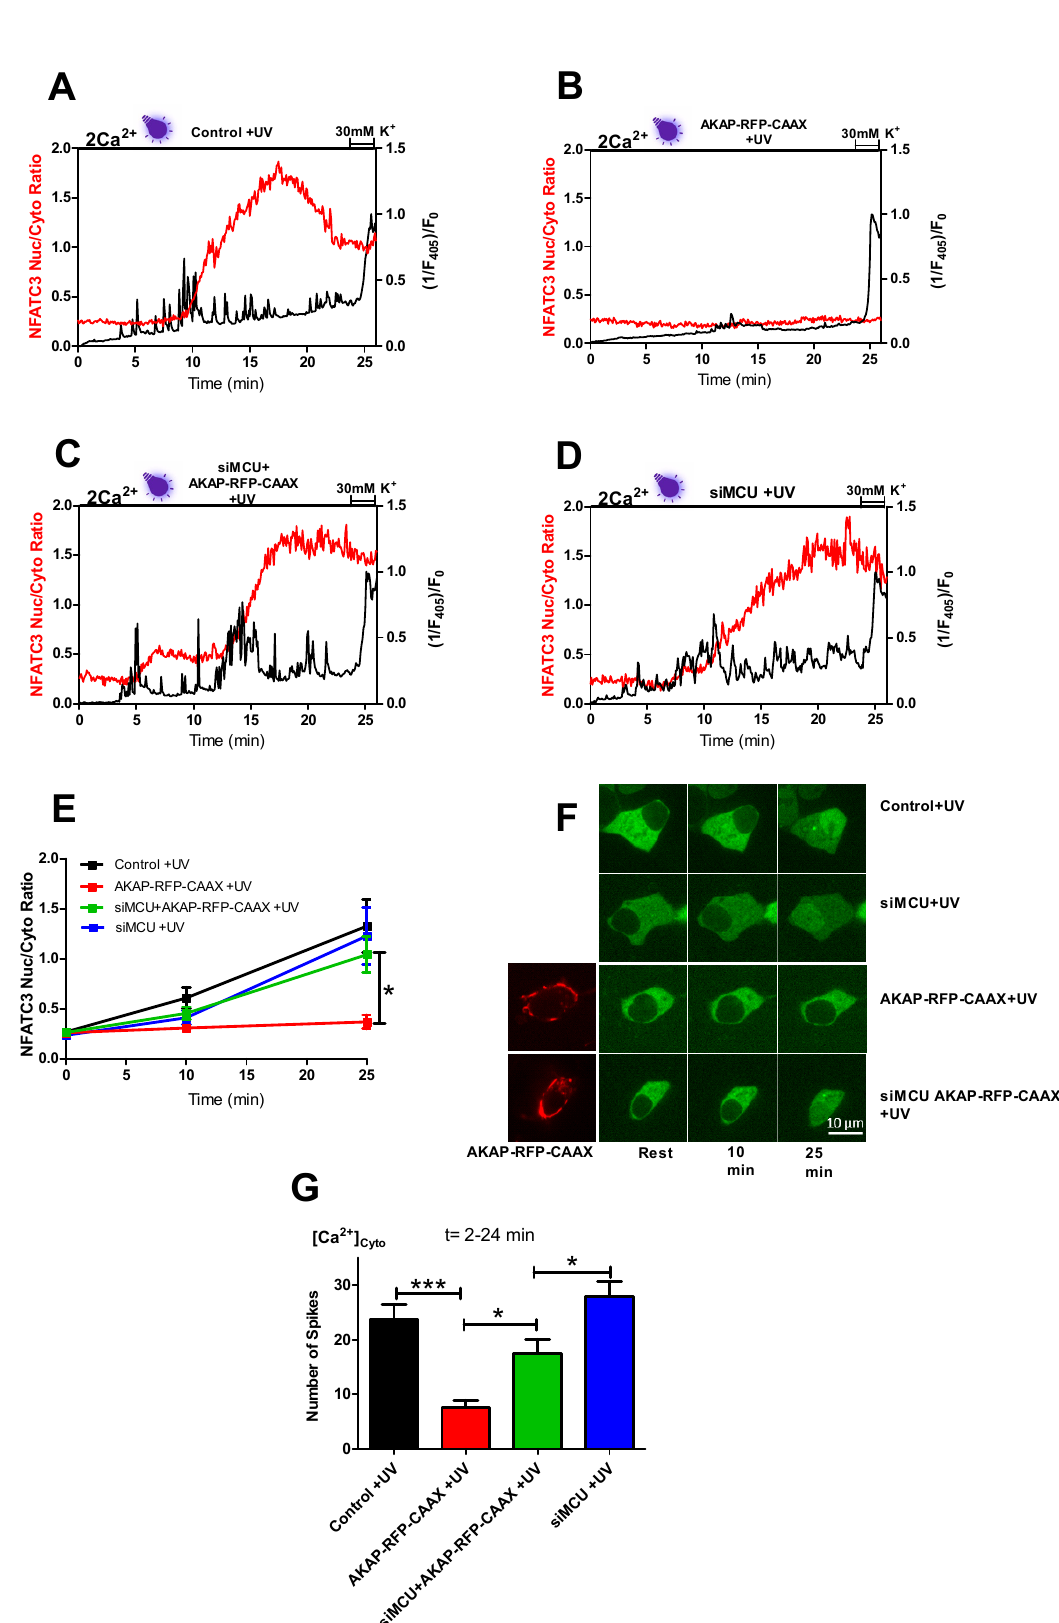
Figure 5. Effect of an enhancement of subplasmalemmal mitochondria’s Ca 2+ buffering ability on near-UV light-induced cytosolic Ca 2+ spiking and GFP-NFATc3 translocation to the nucleus. Representative trace of repetitive cytosolic Ca 2+